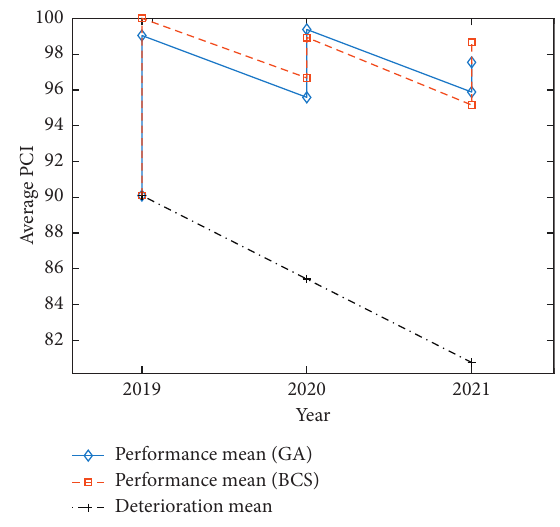
Figure 10: Pavement performance under performance maximization.